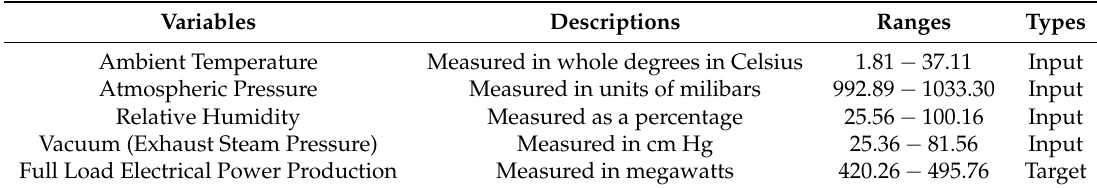
Figure 1. Layout of the combined cycle power plant based on [3]. HP is High Pressure, LP is Low Pressure, D is Drum, G is Generator, SH is Super Heater, E is Evapo, EC is Eco, and HRSG is Heat Recovery Steam Generators. AT, AP, RH, V and PE are the variables described in Table 1. Table 1. Input and target variables of the